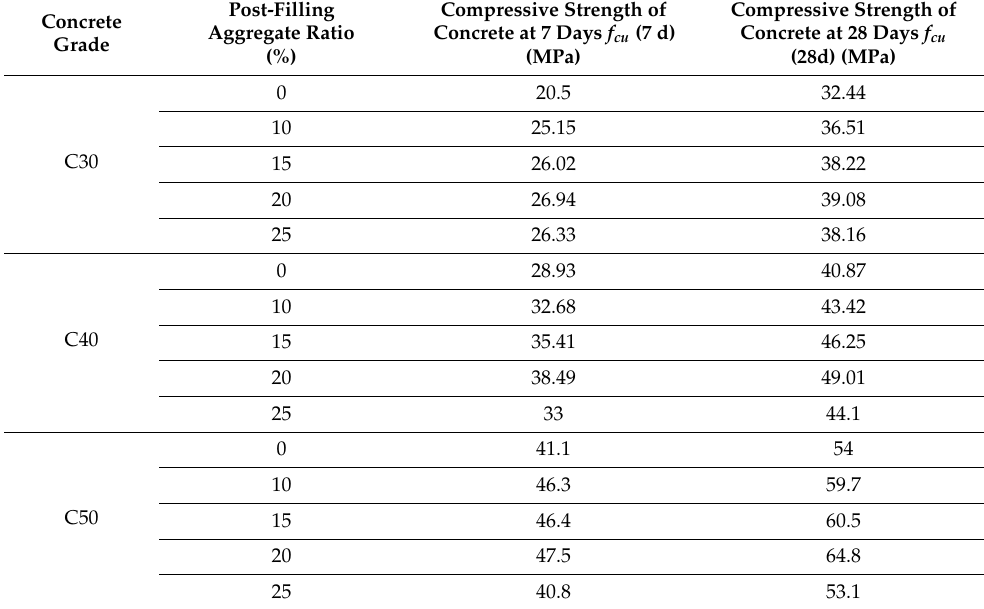
Table 2. Mechanical properties of concrete.